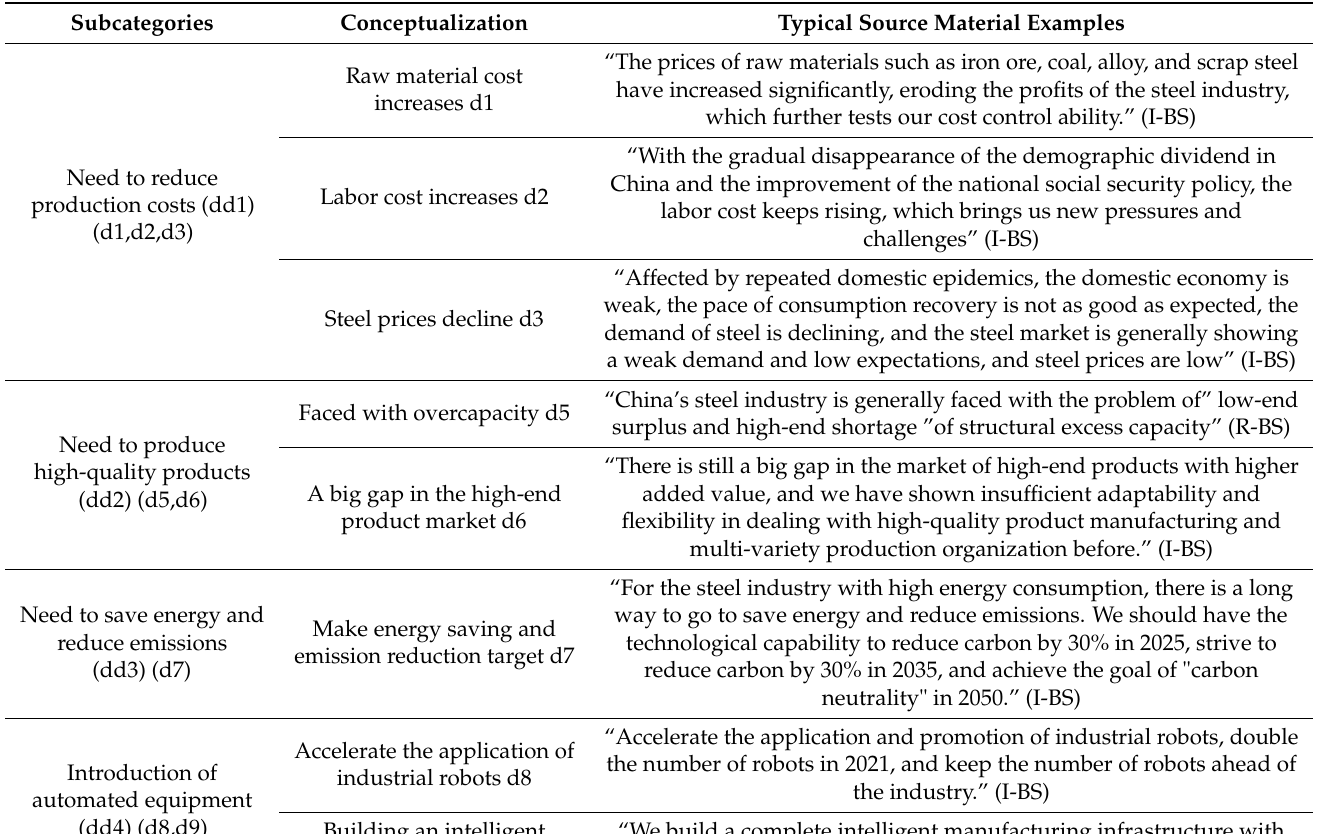
Table 3. Open coding